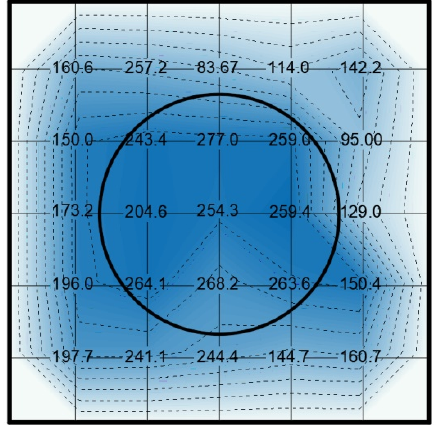
Figure 8. Example of spatial distribution of d 33 constant in a sample charged with a glass dielectric layer with a maximum of 277 pC/N. The numbers indicate the value of the d 33 constant in the measurement points and the circle the position of the high-voltage electrode.